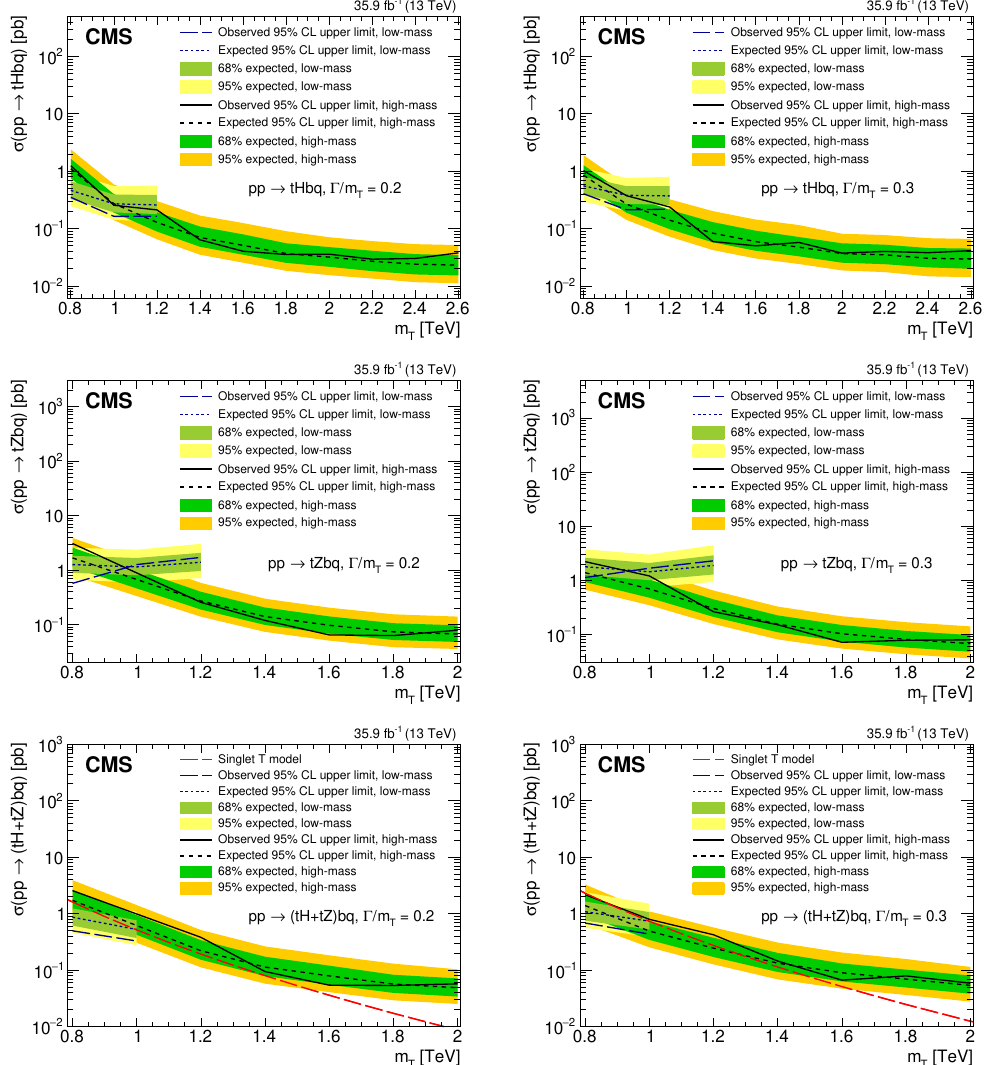
Figure 13 . The observed and median expected upper limits at 95% CL on the cross sections for production associated with a bottom quark for the tHbq (upper row) and tZbq (middle row) channels, and their sum, tHbq + tZbq (lower row), for di(cid:11)erent assumed values of the T quark mass. The inner (green) bands and the outer (yellow) bands indicate the regions containing 68 and 95%, respectively, of the distribution of limits expected under the background-only hypothesis. The left column is for a fractional width of 20% and the right column is for a fractional width of 30%. The dashed red curves are for the T singlet model. Given the speci(cid:12)ed width, the couplings are implicit in the model.